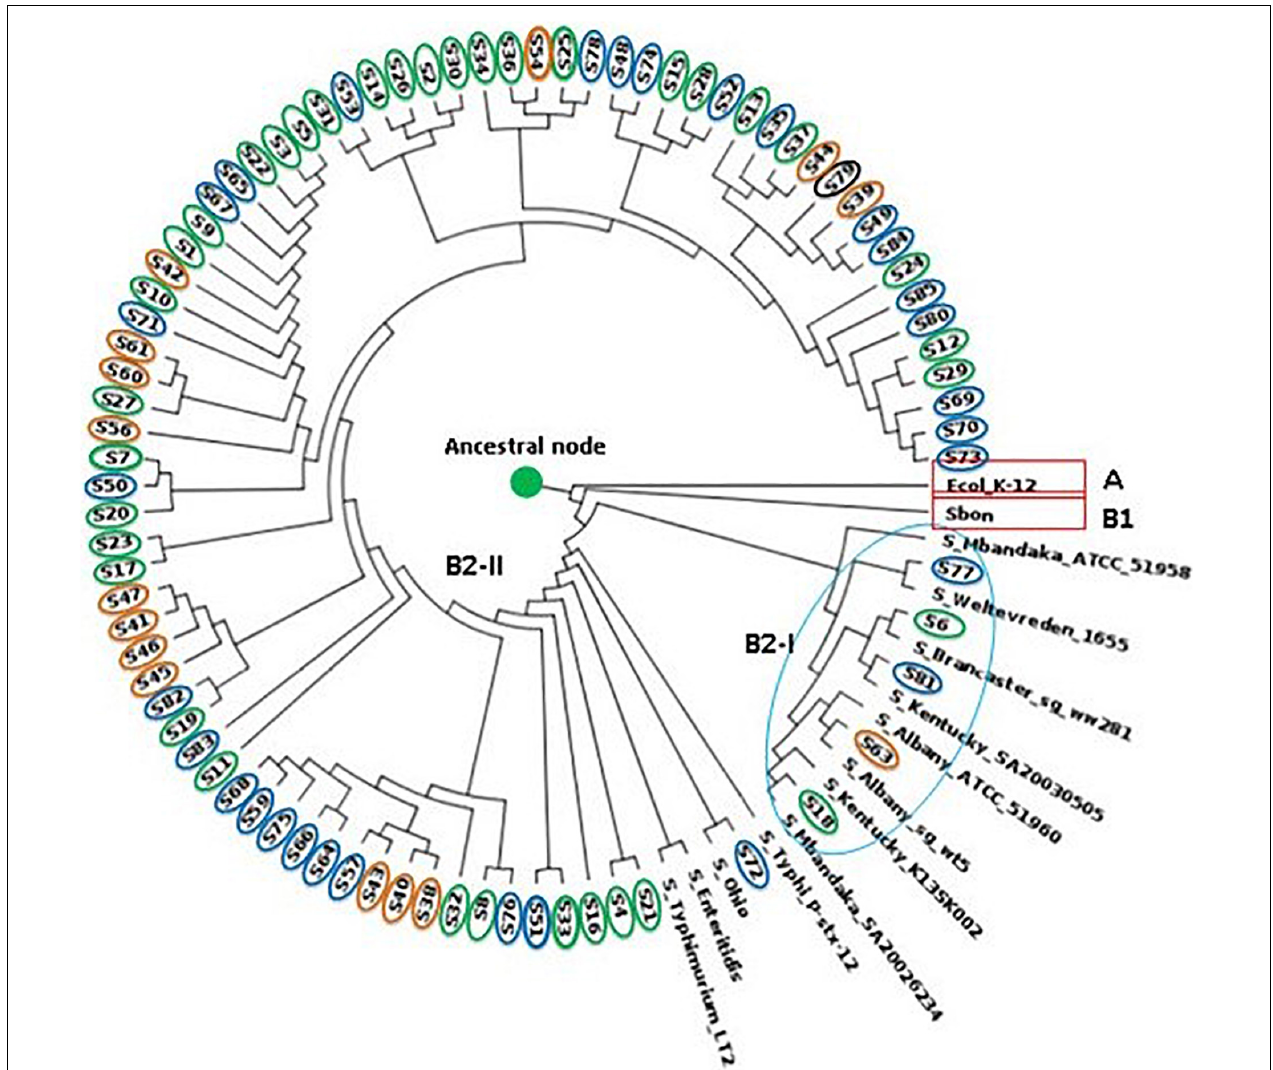
FIGURE 3 | Phylogram showing maximum-likelihood phylogeny of S. Enteritidis calculated using aligned all genome SNPs. Human isolates circled in green, food in orange and chicken isolates in blue.